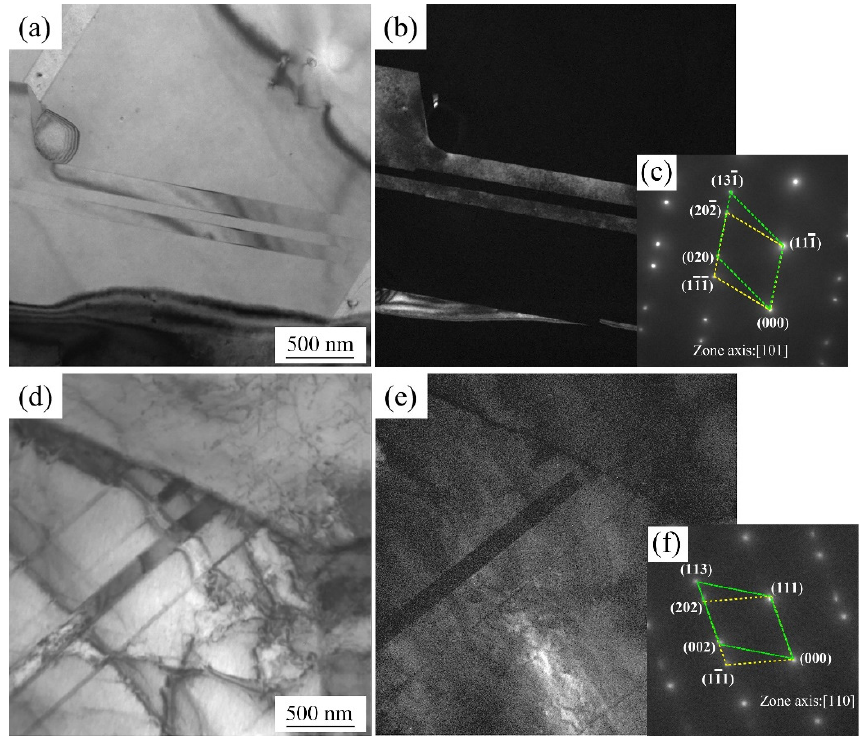
Figure 5. TEM (transmission electron microscopy) micrographs of annealing twins microstructure of steels: ( a – c ) steel 1# and ( d – f ) steel 2# under the solid solution temperature of 850 °C with ( a , d ) bright-field images, ( b , e ) dark-field images and ( c , f ) corresponding selected area electron diffraction (SAED) patterns.